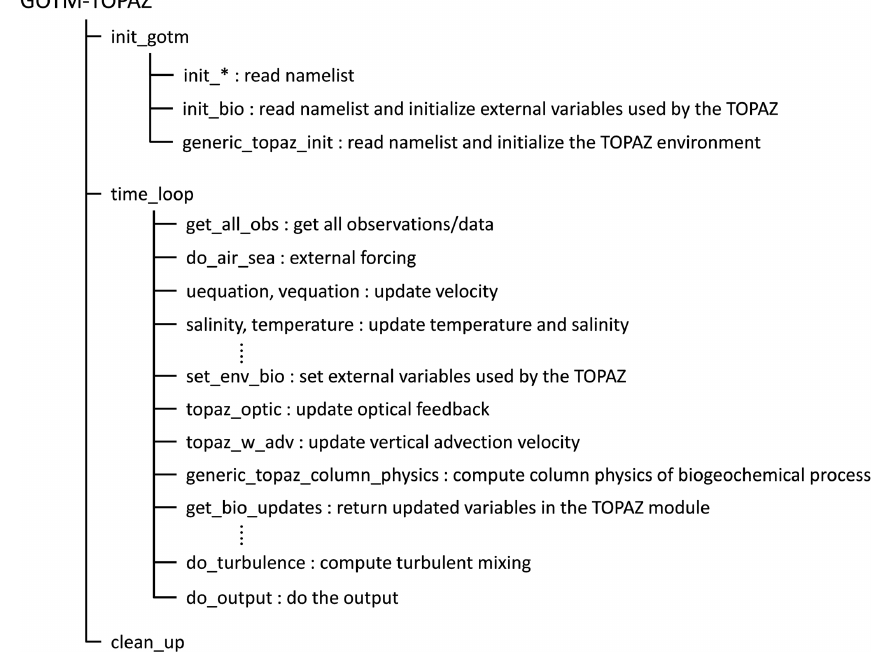
Figure 1. Flow diagram of the Fortran subroutines comprising the Generic Ocean Turbulence Model–Tracers of Phytoplankton with Allo- metric